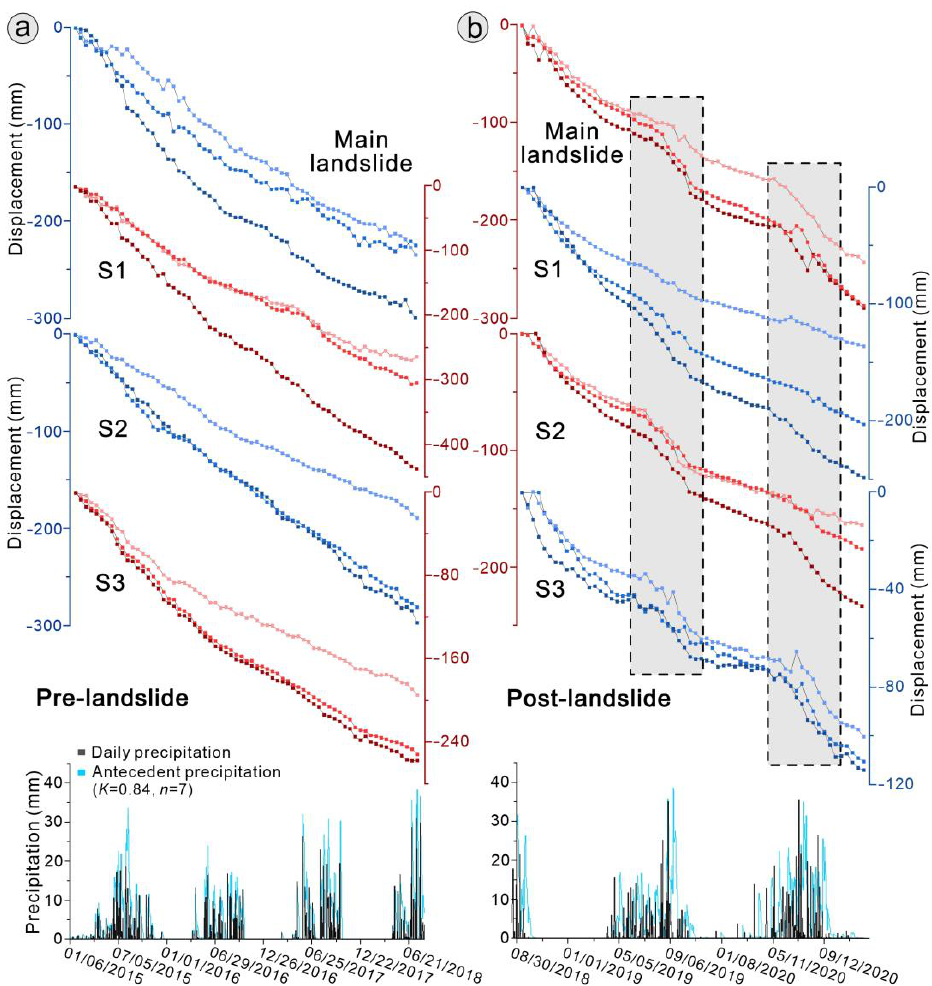
Figure 9. Displacement of landslides and antecedent precipitation. ( a ) Before landslides. ( b ) After landslides.